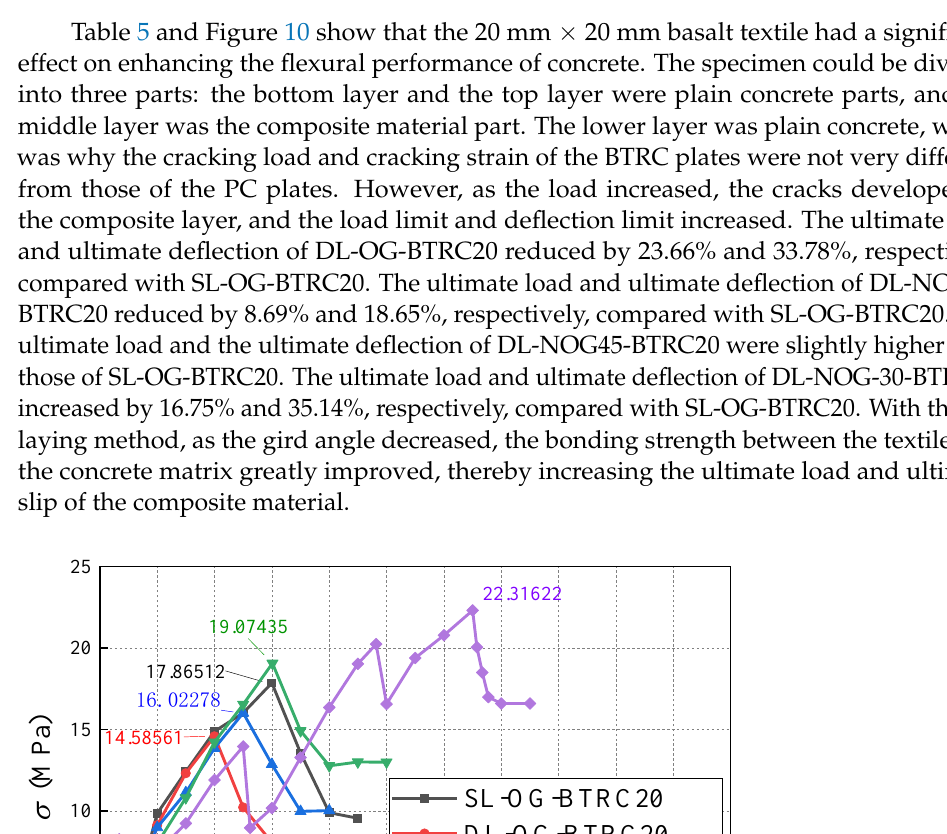
Figure 9. Four-point bending test failure modes of BTRC plates. ( a ) PC; ( b ) BTRC40; ( c ) SL-OG- BTRC20 DL-OG-BTRC20 DL-NOG60-BTRC20; ( d ) DL-NOG45-BTRC20; ( e ) DL-NOG30-BTRC20; ( f ) DL-NOG30-BTRC20.